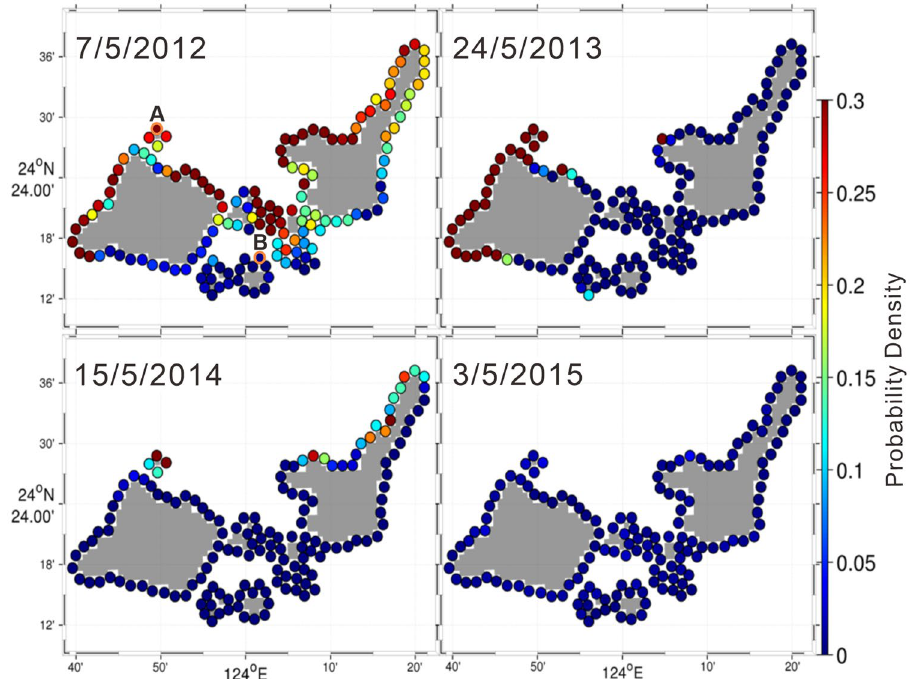
Figure 9. Probability density functions of reachability for long-distance particles during the years 2012–2015. The orange circles (marked ( A , B )) show the northern coast of Hatoma Island and Urabishi reef, respectively.